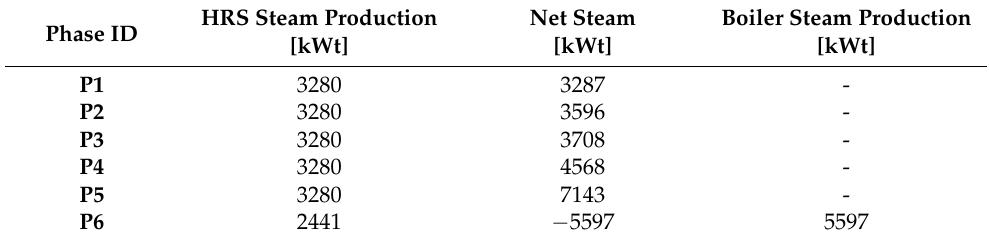
Table 8. Adjusted heat balance of the cruise ship with the SOFC power plant integrated with the heat recovery system.